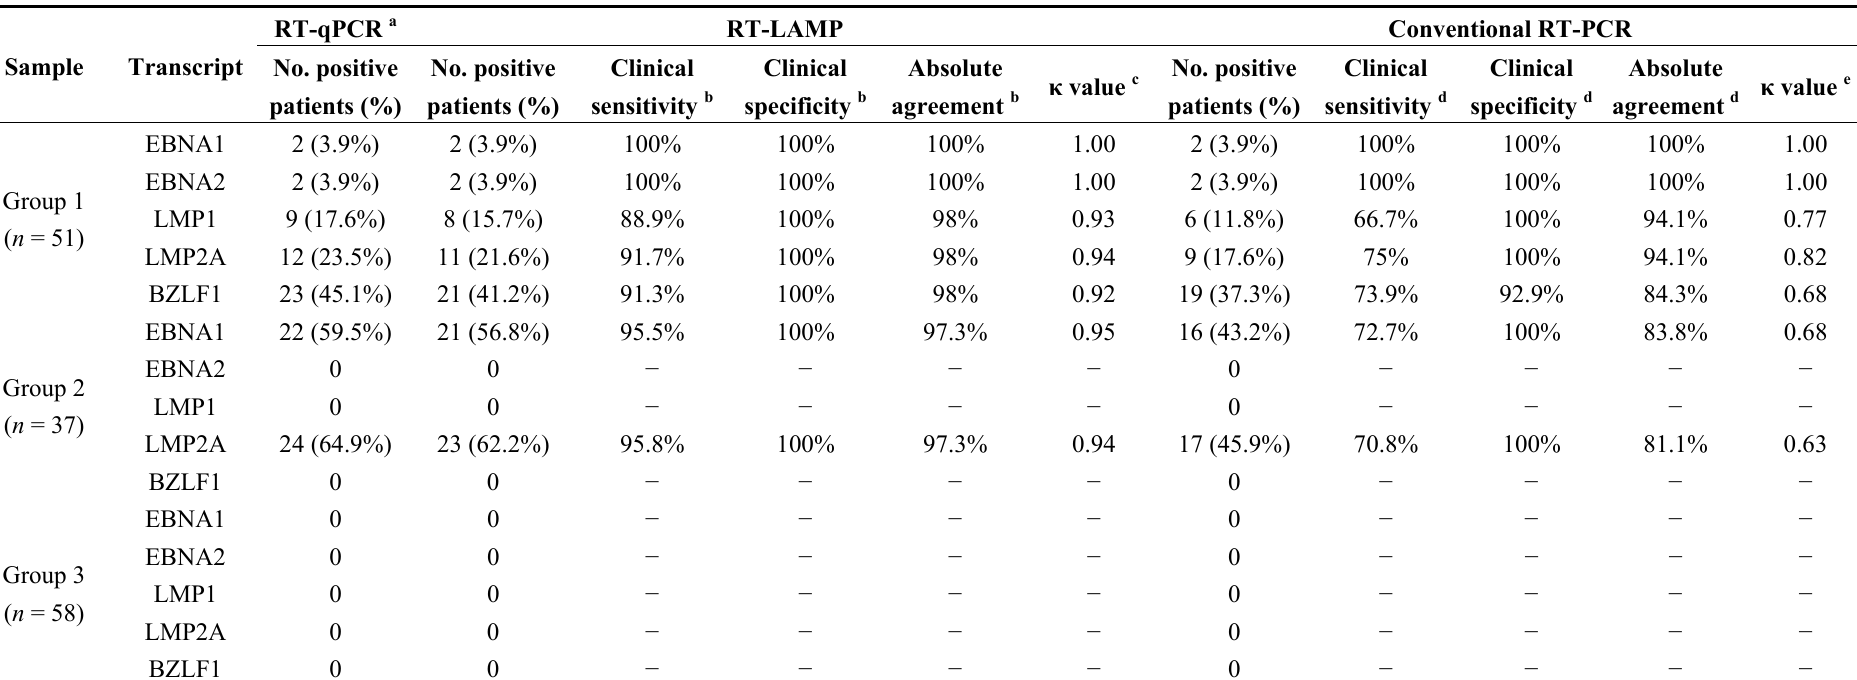
Table 3. Clinical sensitivity and specificity of RT-LAMP, RT-qPCR and conventional RT-PCR for the five EBV-related genes in patients with EBV primary or past infection and control